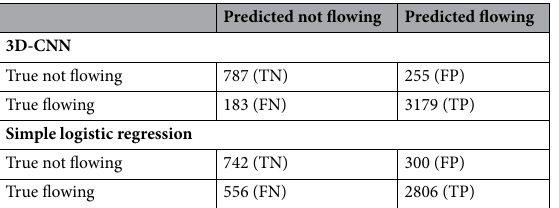
Table 1. Confusion matrix of 3D-CNN on test set: accuracy of prediction (n = 4404 data points). TN true negative, FP false positive , FN false negative , TP true positive.